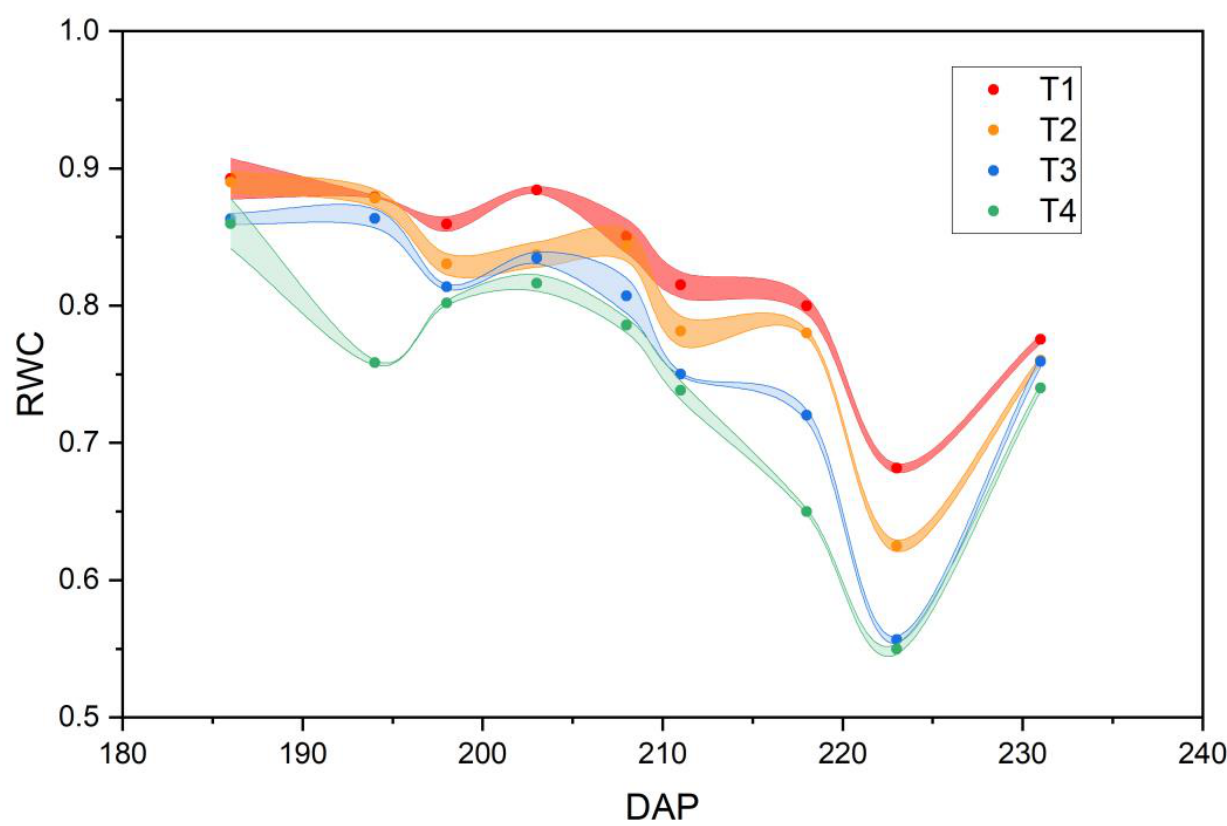
Figure 9. Seasonal variations of the relative water content (RWC) under different water stresses. Each point and bar indicate the mean value ± standard deviation (SD). DAP means days after planting.